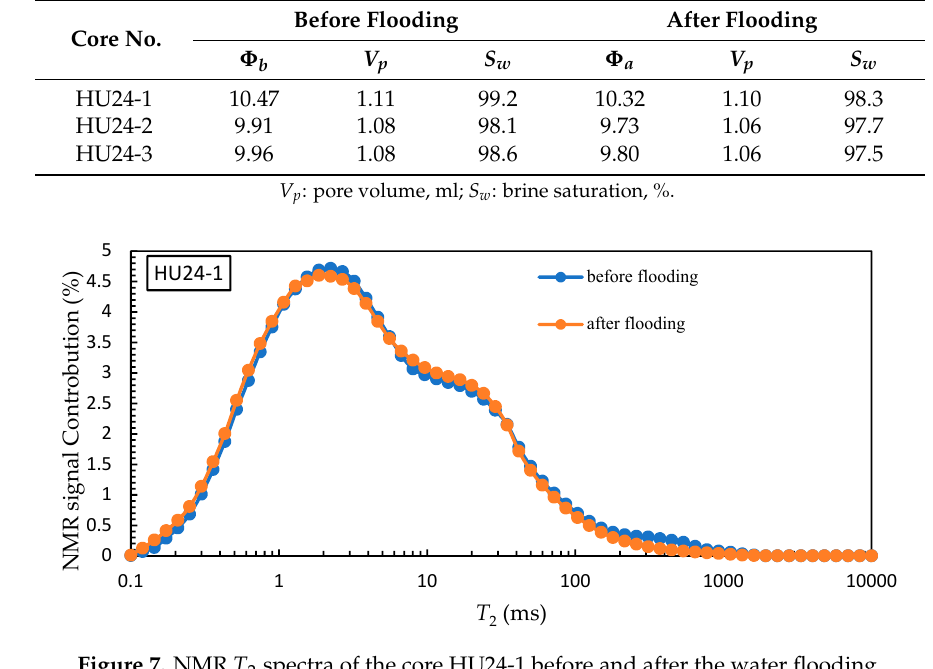
Figure 7. NMR T 2 spectra of the core HU24-1 before and after the water flooding.